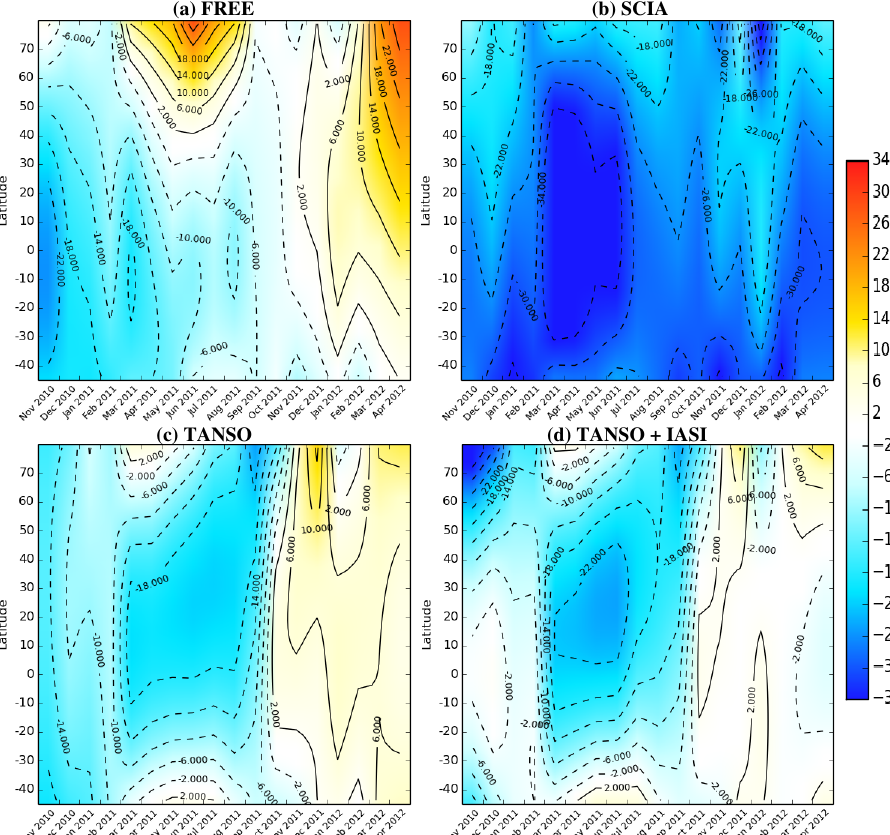
Figure 11. Time series of the monthly average smooth xCH 4 difference (in ppb) between the experiments and the measurements from the Fig. 11. Time series of the monthly average smooth x CH 4 difference (in ppb) between the experiments and the measurements from the TCCON network: (a) FREE, (b) SCIA, (c) TANSO and (d) TANSO + IASI TCCON network: (a) FREE, (b) SCIA, (c) TANSO and (d) TANSO + IASI experiments.